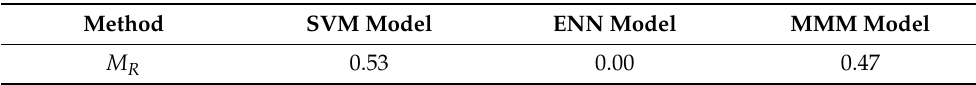
Table 4. Results of the combined assessment of the three models.